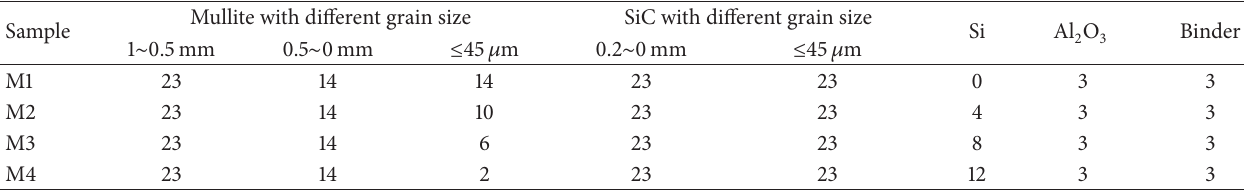
Table 1: Compositions of the